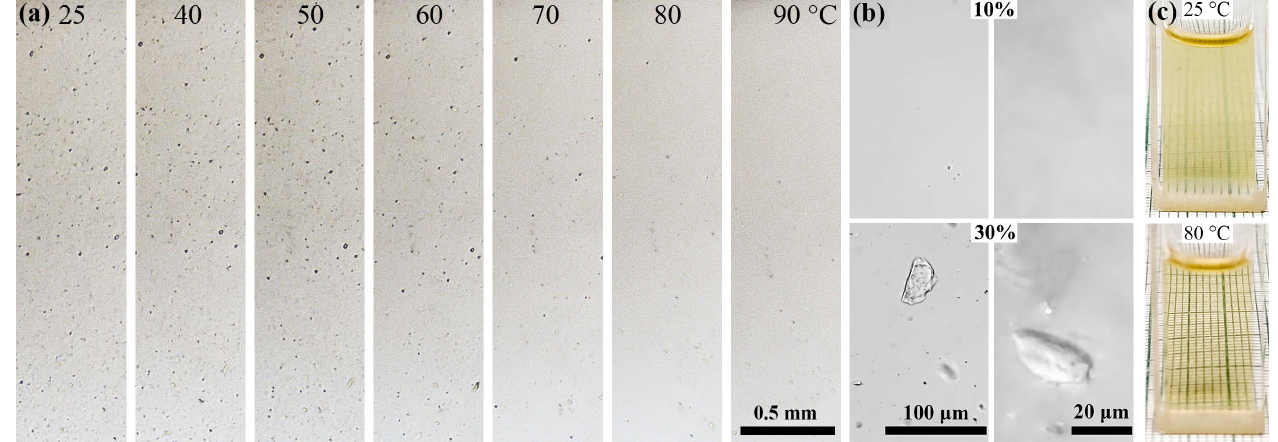
Figure 5. Changes in the morphology of a 35% PAN-LA1 solution in DMSO upon heating ( a ); images of PAN-LA1 solutions with the concentrations of 10% and 30% at 25 °C ( b ); and images of the 15% PAN-LA1 solution at 80 °C and 25 °C (4 h after heating) ( c ).